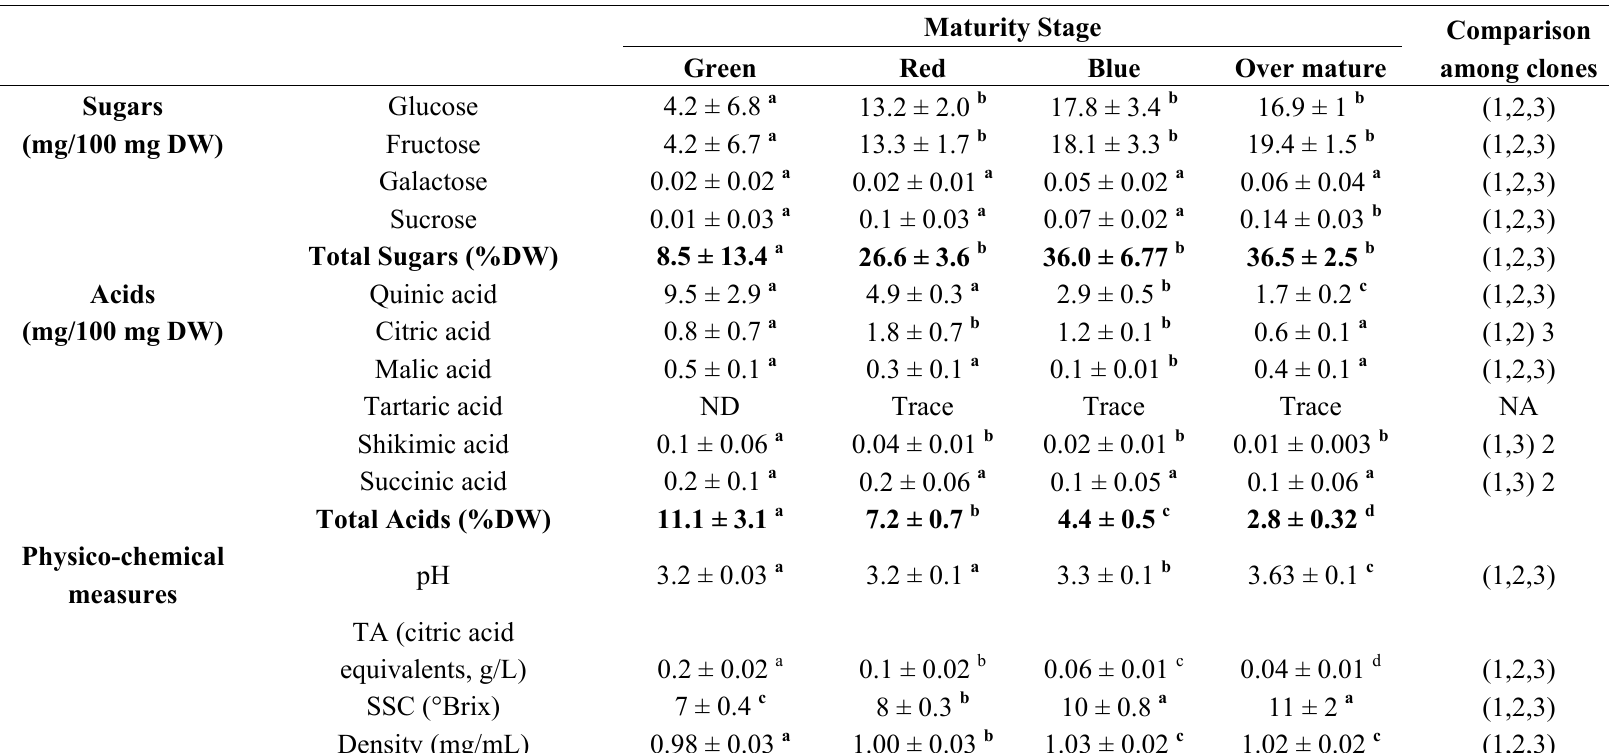
Table 3. Sugar, organic acid content and selected physico-chemical measures of four maturity stages in lowbush